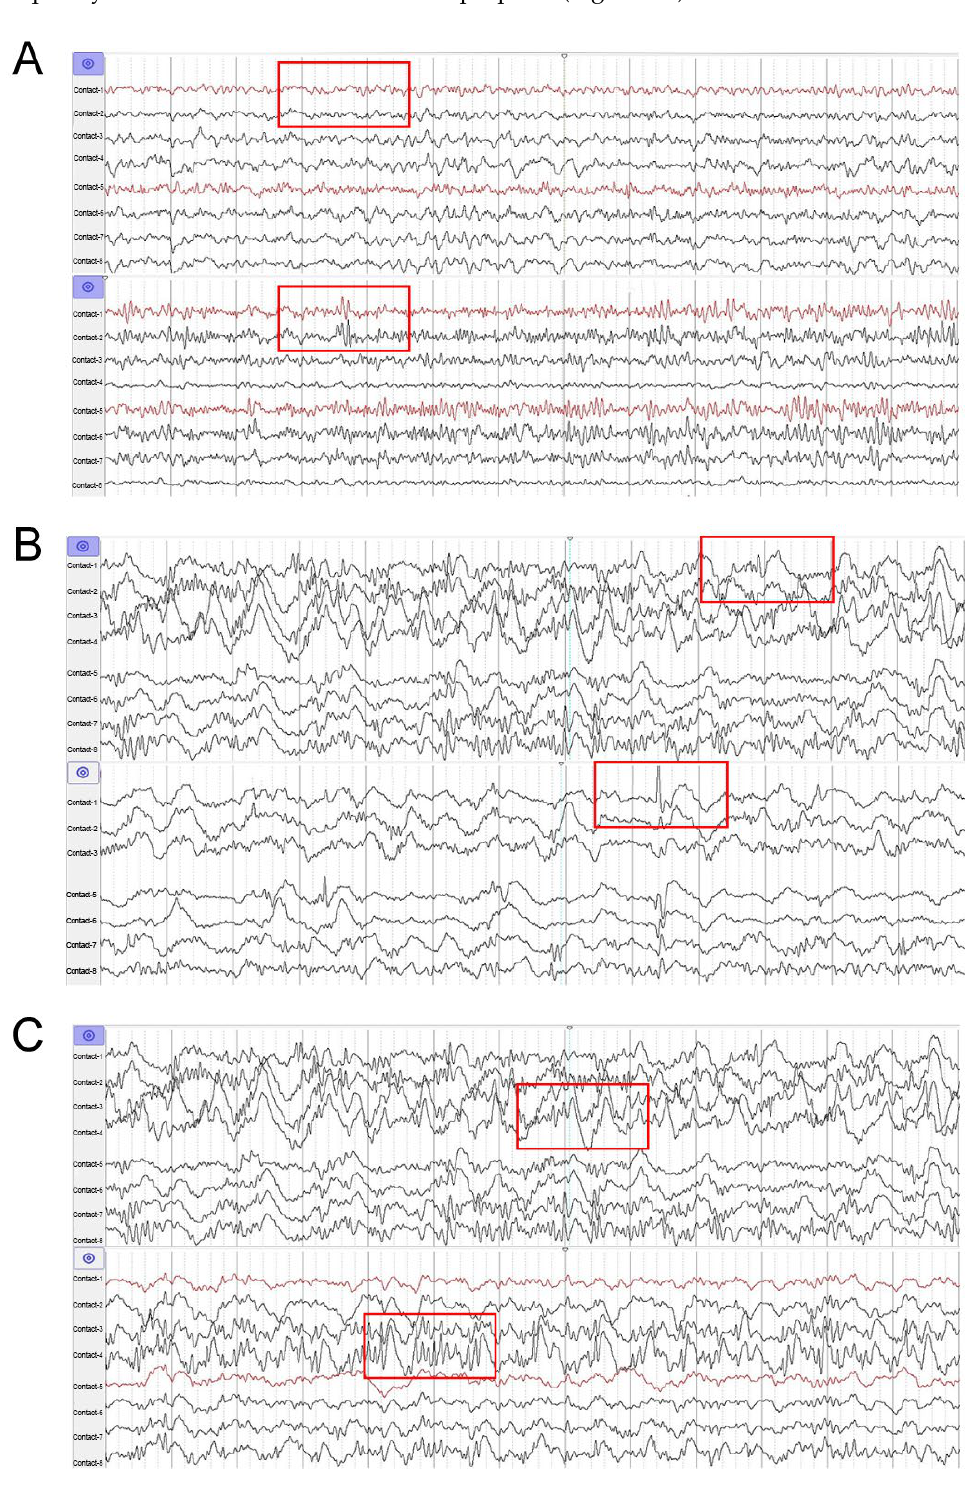
Figure 3. Three forms of ECoG activation by infusion of low-dose propofol. ( A ) Contact-2, the newly emerging IEDs after low-dose propofol injection. ( B ) Contact-1, the increased amplitude of IEDs after low-dose propofol injection. ( C ) Contact-4, the increased frequency of IEDs after low-dose propofol injection. (The most obvious changes in ECoG were marked with red